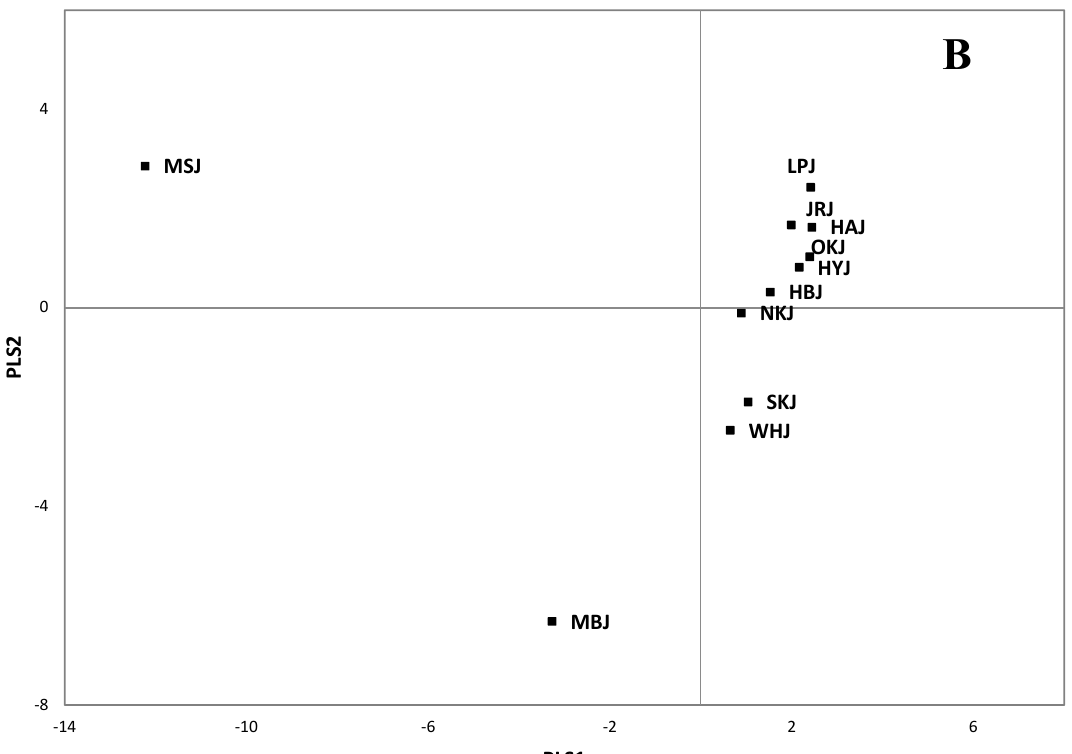
Figure 3. Correlation loadings ( A ) from PLS of 59 volatile compounds (X) and 12 sensory attributes (Y), and samples scores ( B ) of 11 commercially distilled soju samples (closed squares). Explained variance for X (GC data) is 37.9% and 13.1% for PC1 and PC2, respectively, and for Y (Sensory data) is 22.4% and 24.7%, respectively. The sample and volatile compound codes are defined in Tables 1–3.